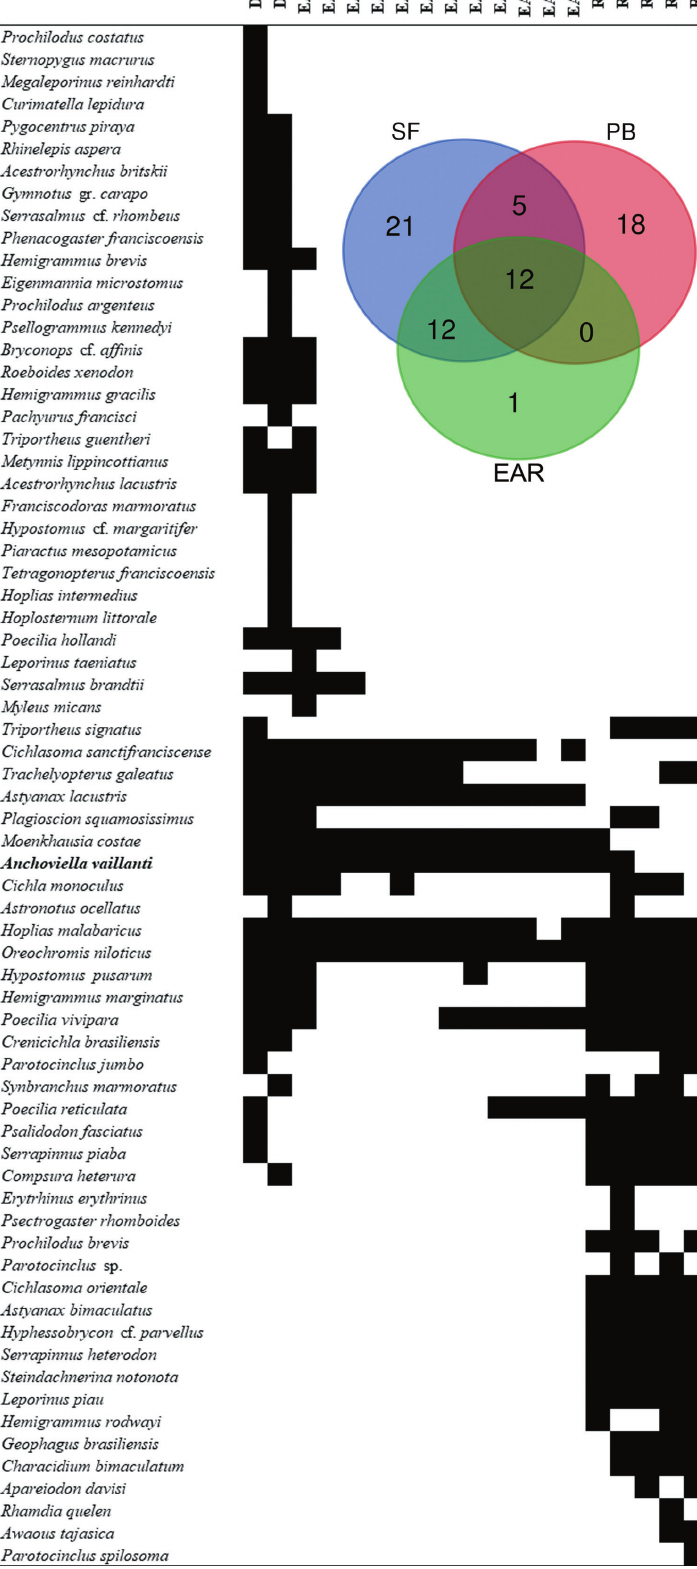
FIGURE 2 | Seriated ordination of the species presence/ absence at the sampling sites of the East Axis of the São Francisco River Integration Project (SF-IWT). Black cells represent the presence of the species at a particular location. The species written in bold represents the new occurrence record in the receiving basin. In the upper right corner, Venn diagram showing species richness interactions between groups of sites. SF = São Francisco River basin, PB = Paraíba do Norte River basin, EAR = East Axis